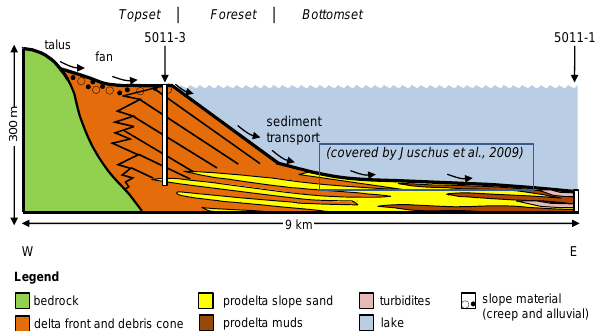
Fig. 9. A proposed simplified view of the El’gygytgyn western margin that combines known lithologies of cores 5011-3 and 5011-1 and studies of mass movements on the lake floor by Juschus et al. (2009). Note that the bottom of core 5011-3 encounters sediments from the deeper slope area. Turbidites known from core 5011-1 are expected in the deeper basin as a continuation of the prograding sediment transport from the west.